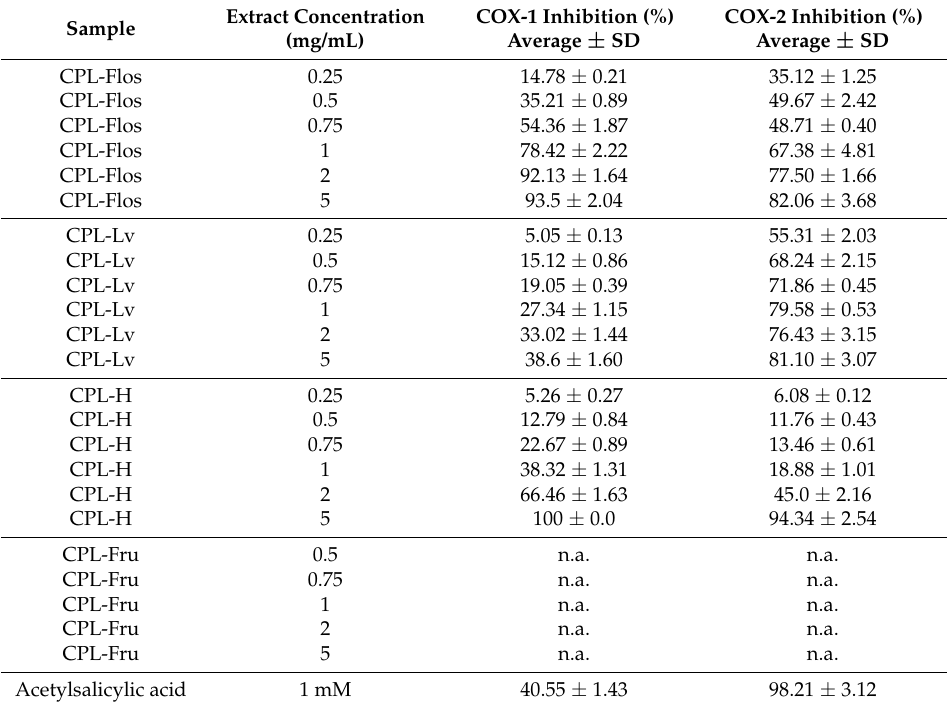
Table 3. Inhibition of COX-1 and COX-2 activity in the presence of R. rugosa crude polysaccharides. Abbreviations: n.a.—no activity observed, other abbreviations like in Table